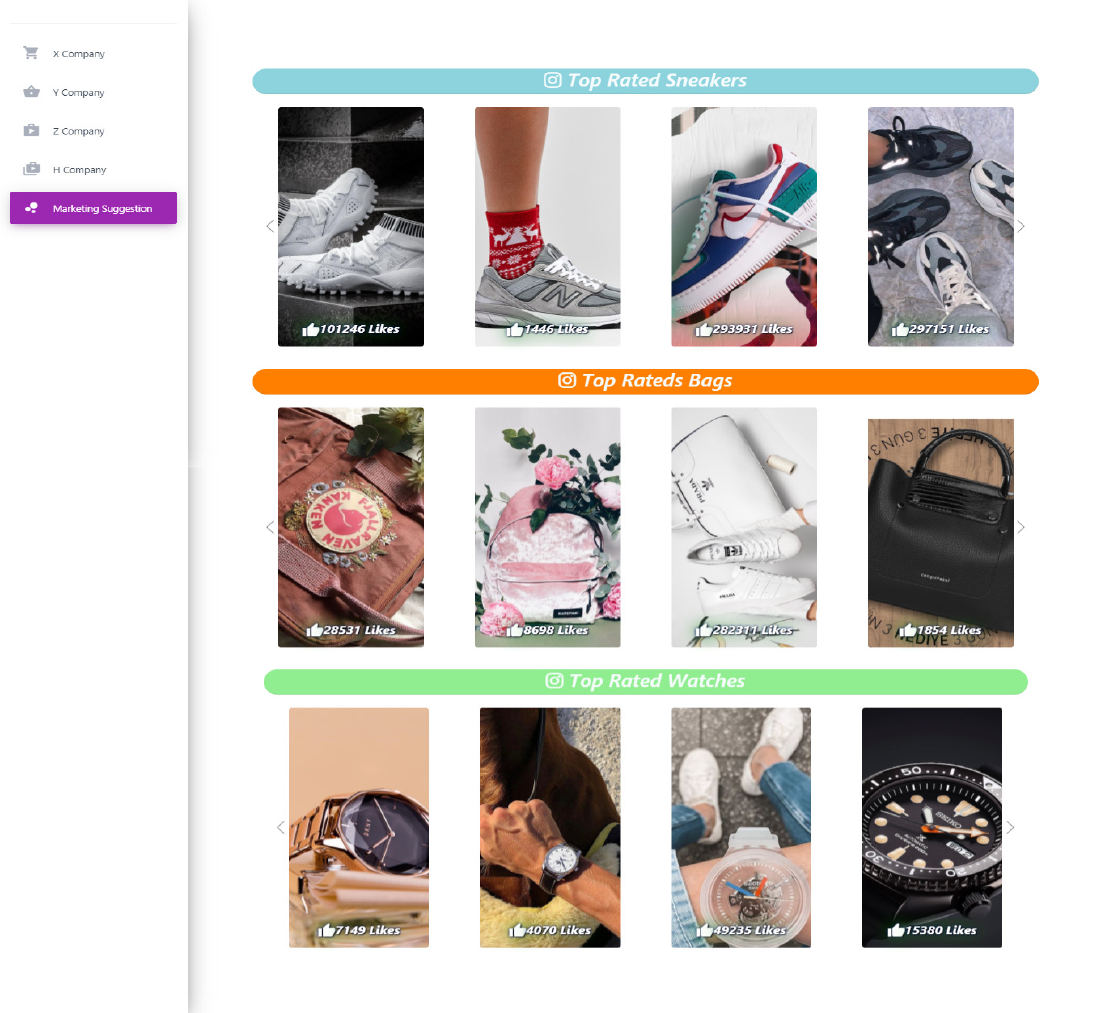
Figure 5. Interface of marketing suggestion